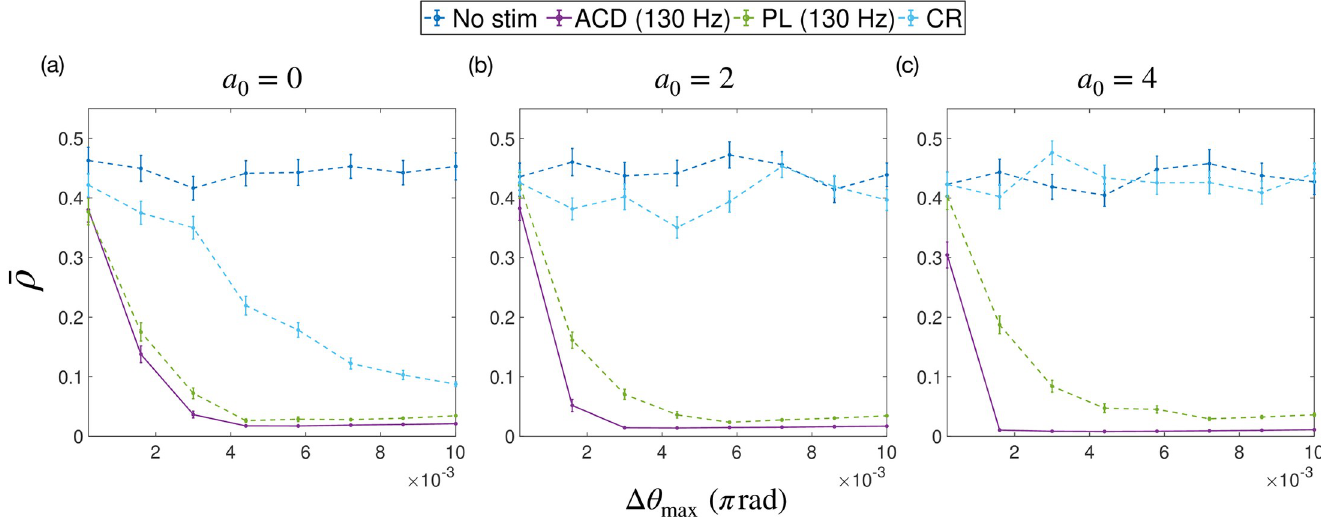
Fig 7. The average amplitude of simulated data � r as a function of the stimulation intensity Δ θ max . The strategies tested were: no stimulation (no stim), adaptive coordinated desynchronisation (ACD), phase-locked (PL) and coordinated reset (CR). The average amplitude is a measurement of efficacy, where lower amplitudes indicate higher efficacy. The maximum stimulation frequencies used for ACD and PL are also given in the legend. Each sub plot shows a set of simulations performed with a particular zeroth harmonic of the uPRC a 0 .